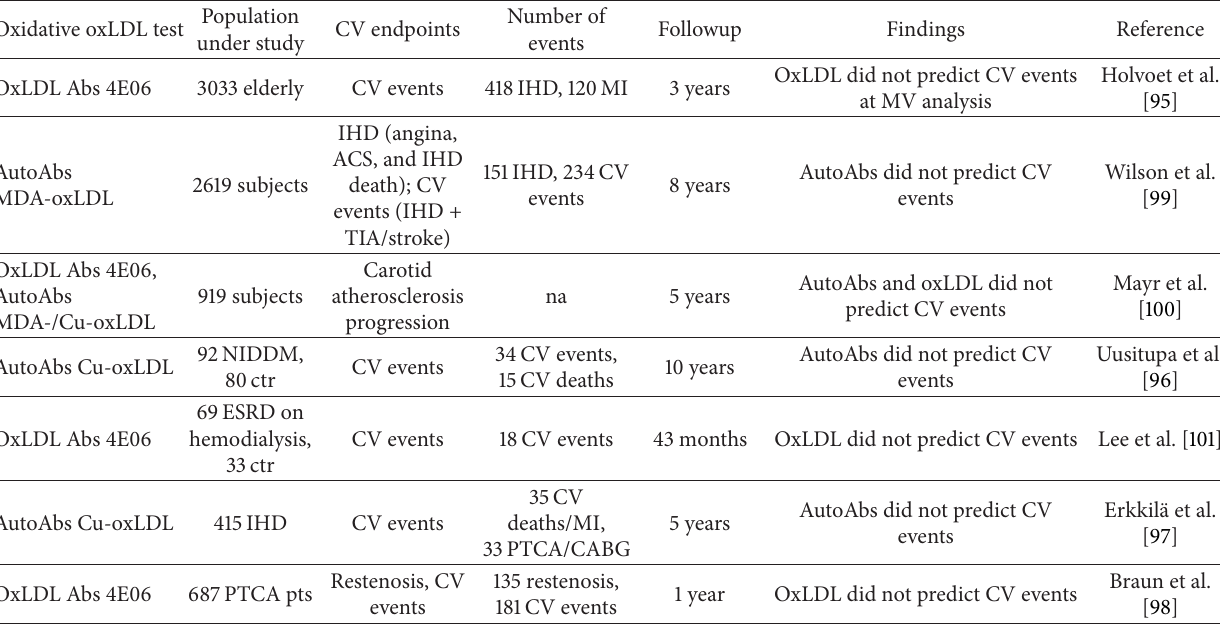
Table 2: Cohort studies demonstrating no association between oxidized low-density lipoprotein measurement and cardiovascular events. Population Oxidative oxLDL test under study